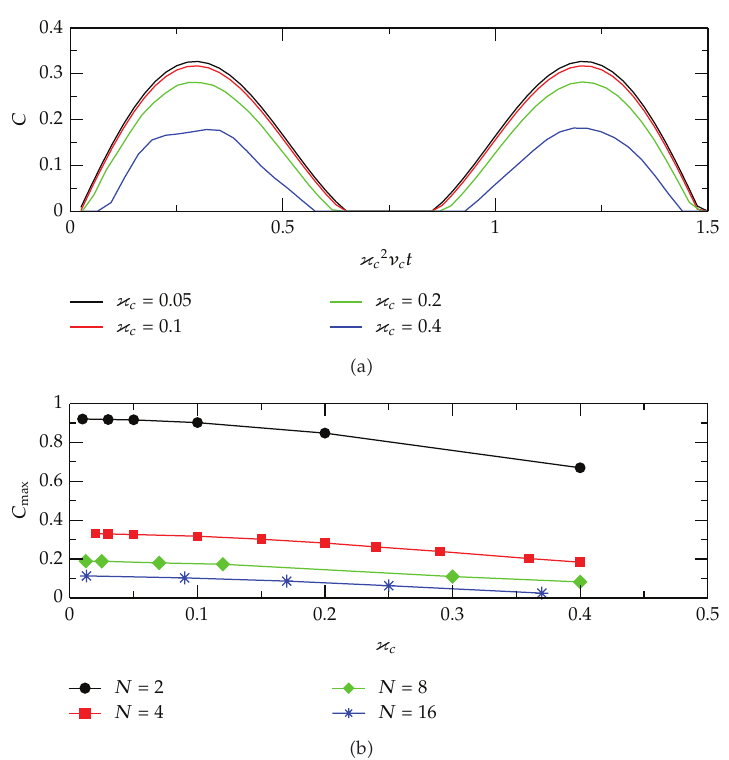
Figure 2: (cid:2) a (cid:3) Concurrence as a function of the rescaled time, for di ff erent κ c and fixed (cid:9) (cid:8) ν c /ν T (cid:8) 1, being respectively the cut-o ff and thermal frequency (cid:2) ν T (cid:8) k B T/h with T (cid:8) 300K (cid:3) and the form factor (cid:4) f c (cid:2) k (cid:3) (cid:8) | k | . Other data are p (cid:8) 0 . 5 ,v (cid:8) 0 . 48, N (cid:8) 4. (cid:2) b (cid:3) Plot of the concurrence at the peak (cid:2) obtained from (cid:2) a (cid:3)(cid:3) as a function of the coupling strength, κ c , for di ff erent N values as indicated in the legend. Other values are the same as in (cid:2) a (cid:3)